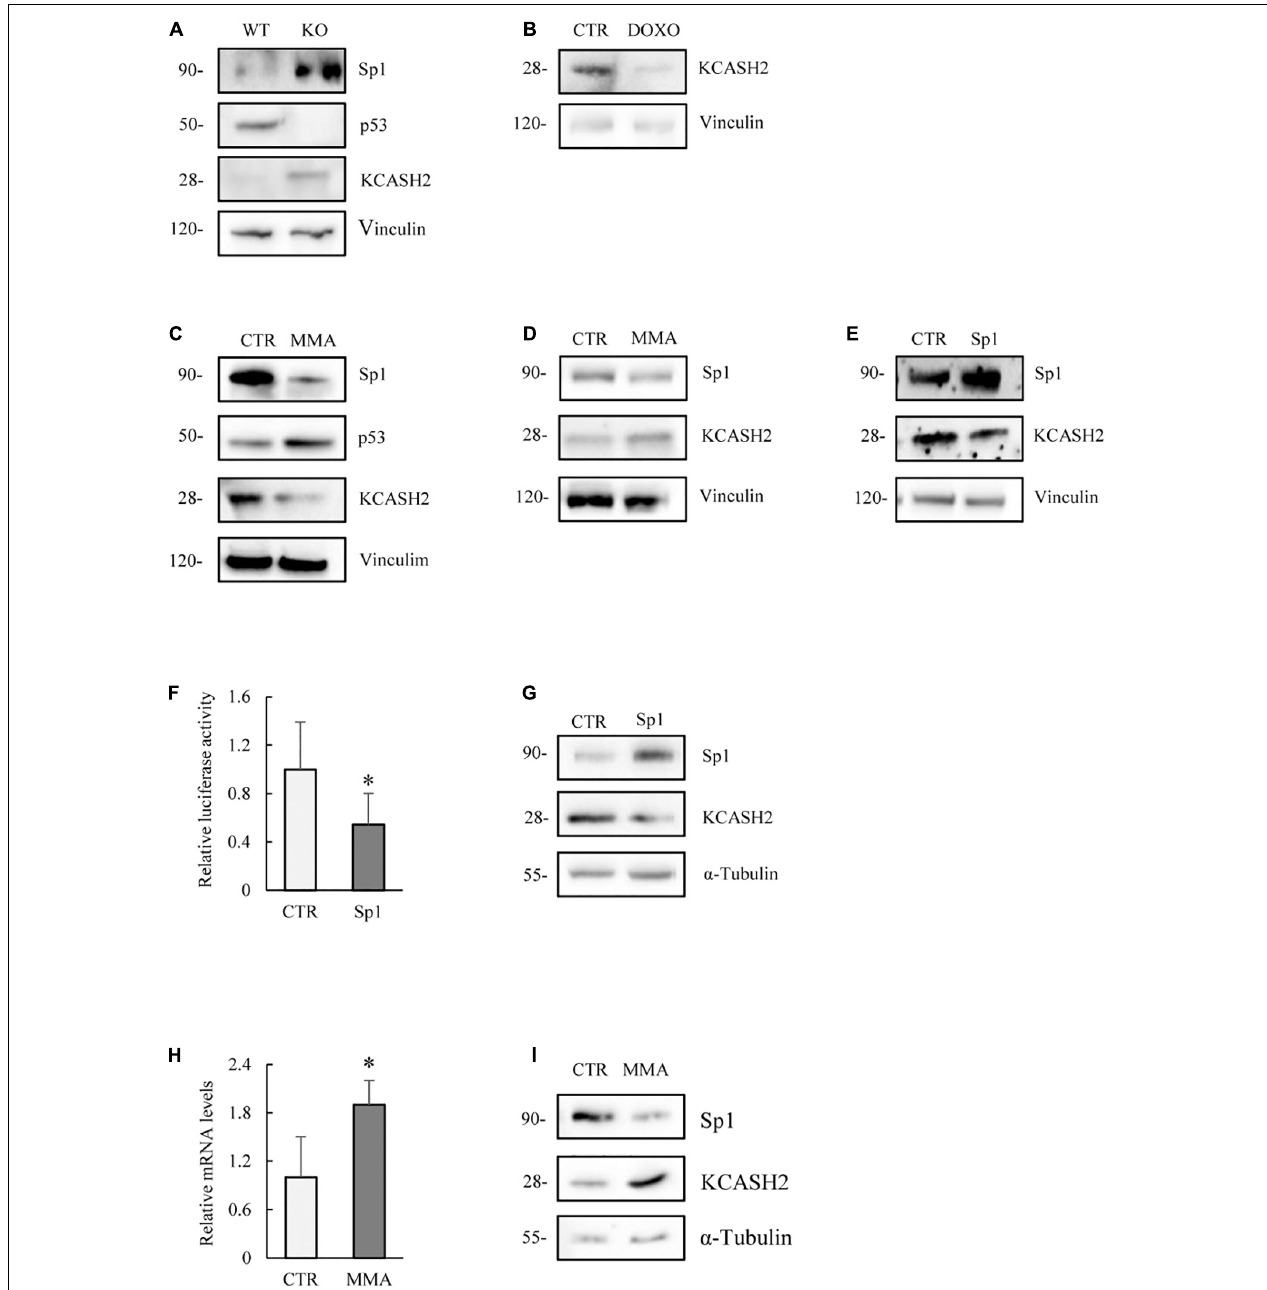
FIGURE 6 | Analysis of the modulation of KCASH2 expression in cells lacking p53 activity. (A) MEF p53 − / − present increased endogenous Sp1 and KCASH2 protein levels. Protein lysates of MEF WT and p53 − / − were analyzed by Western blot. Anti-Vinculin is shown as loading control. (B) DOXO treatment reduces KCASH2 protein levels in MEF p53 − / − . MEF p53 − / − cells were treated with DOXO (5 µ M) for 10 h, then cells were lysed and analyzed by Western blot. Anti-Vinculin was used as loading control. (C) MMA treatment depletes KCASH2 protein levels and increases p53 stability in MEF WT. MEF WT were cultured with MMA (500 nM) for 24 h, then protein lysates were analyzed by Western blot. Anti-Vinculin is shown as loading control. (D,E) Sp1 negatively regulates KCASH2 in MEF p53 − / − . (D) MEF p53 − / − were treated with MMA (500 nM) for 24 h and protein lysates analyzed by Western blot. Anti-Vinculin was used as loading control. (E) MEF p53 − / − were transfected with empty vector or Sp1 expressing plasmid, then protein lysates analyzed by Western blot. Vinculin was used as loading control. (F,G) Sp1 overexpression reduces KCASH2 activity in p53 mutant DAOY cells. (F) DAOY were co-transfected with KCASH2-Luc reporter, together with control vector or Sp1 plasmid expression. Luciferase activity is normalized to the control and represented as mean of three independent experiments ± SD. ∗ p < 0.05. (G) DAOY were transfected with empty vector or Sp1 expressing vector. Protein lysates were assayed by Western Blot. Tubulin was used as loading control. (H,I) Sp1 inhibition leads to an increase of KCASH2 mRNA and protein levels. (H) DAOY cells were cultured with MMA (30 nM) for 12 h. KCASH2 mRNA levels were assayed through RT-qPCR, normalized to GAPDH, HPRT, and Actin, and represented as fold-induction on the CTR. Bars represent the mean of three independent experiments ± SD. ∗ p < 0.05. (I) Following MMA treatment, DAOY protein lysates were analyzed by Western Blot. Tubulin was used as loading control.